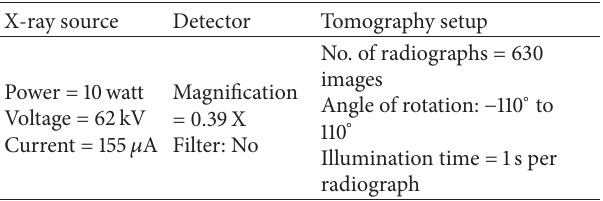
Table 1: Tomography acquisition parameters used during